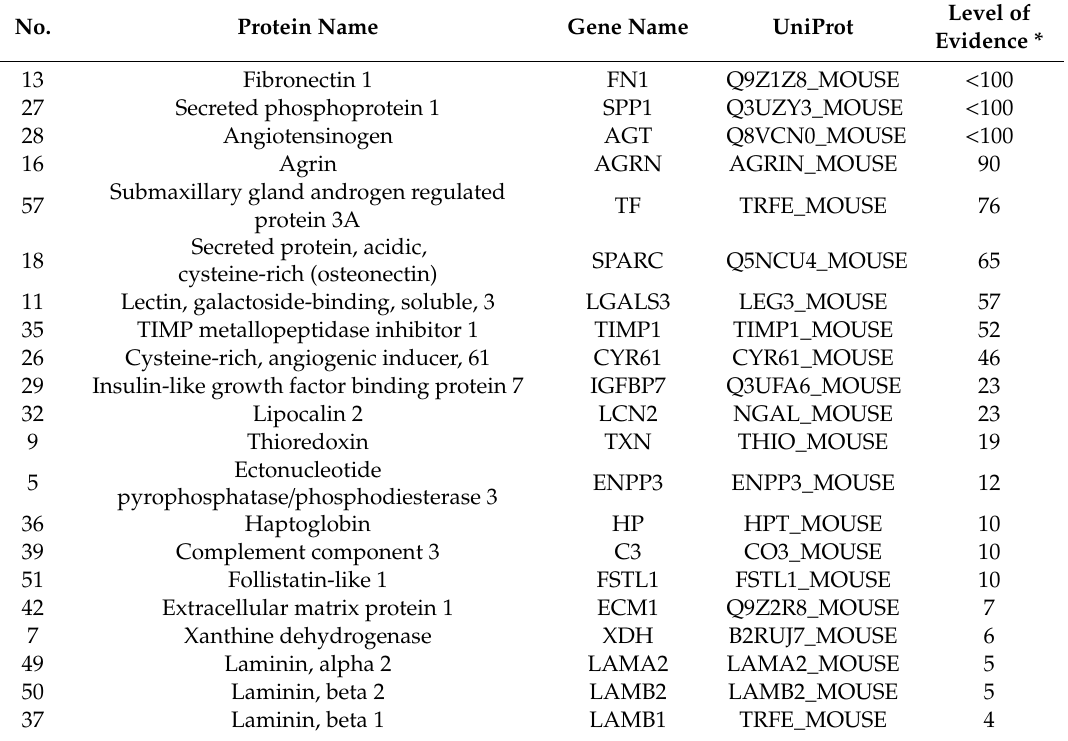
Table 2. List of 21 secreted proteins involved in cell di ff erentiation as reported in the literature.